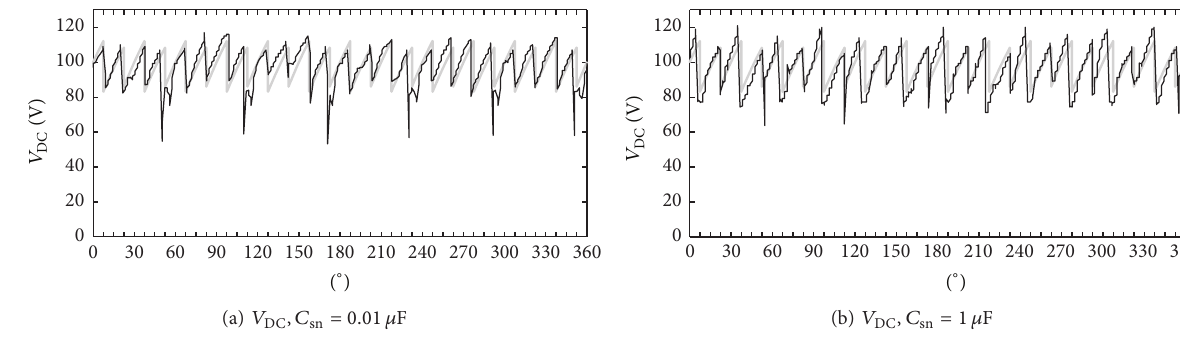
Figure 32: Three-level MLCR CSC DC voltage waveform 𝑉 DC